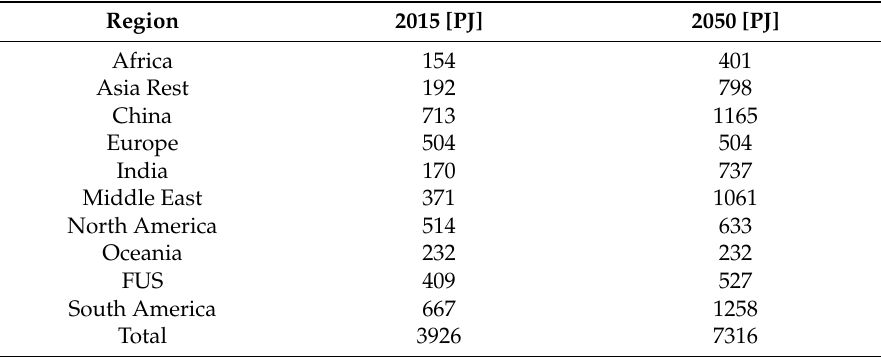
Table 5. Biomass—Regional Potential.